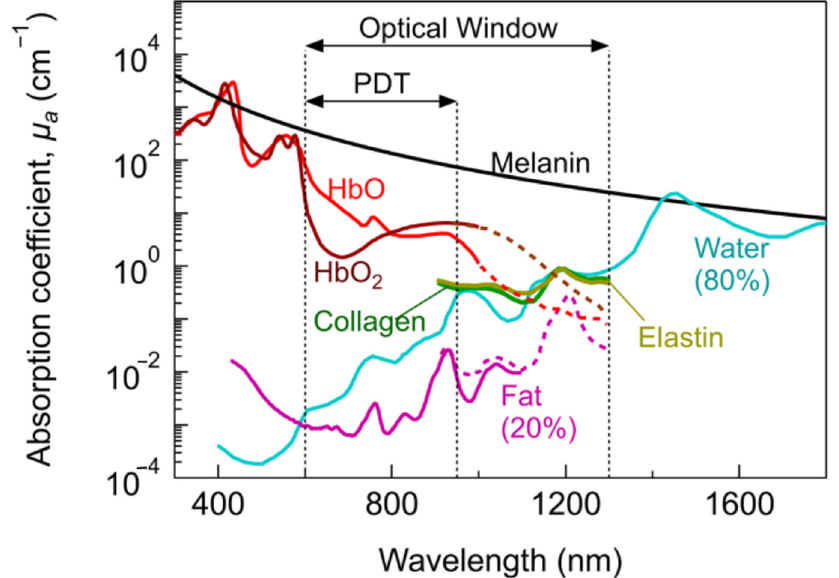
Figure 1. The therapeutic optic window; the absorption coefficient as a function of wavelength for several biologically relevant molecules, where HbO refers to hemoglobin, and HBO 2 refers to oxyhemoglobin, as published by Algorri et al. [9].